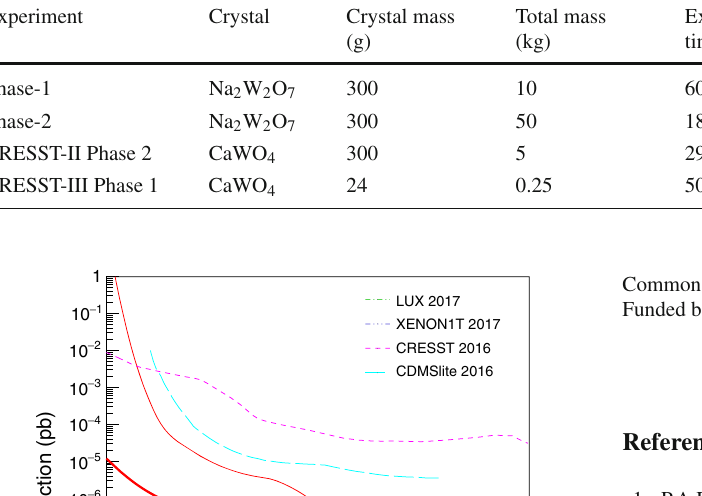
Energy Background time (kgdays) threshold (keV) (counts/keV/kg/day)